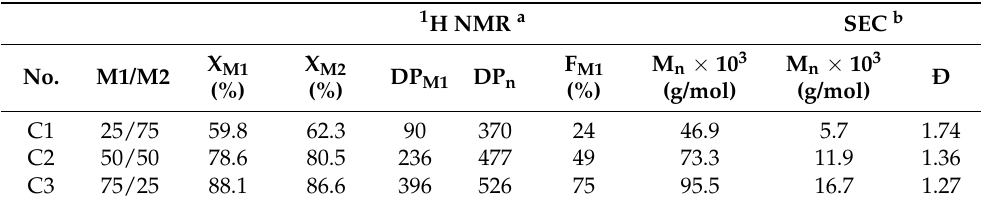
Table 1. Characteristics of linear copolymers based on choline ionic liquid (IL) synthetized by atom transfer radical polymerization